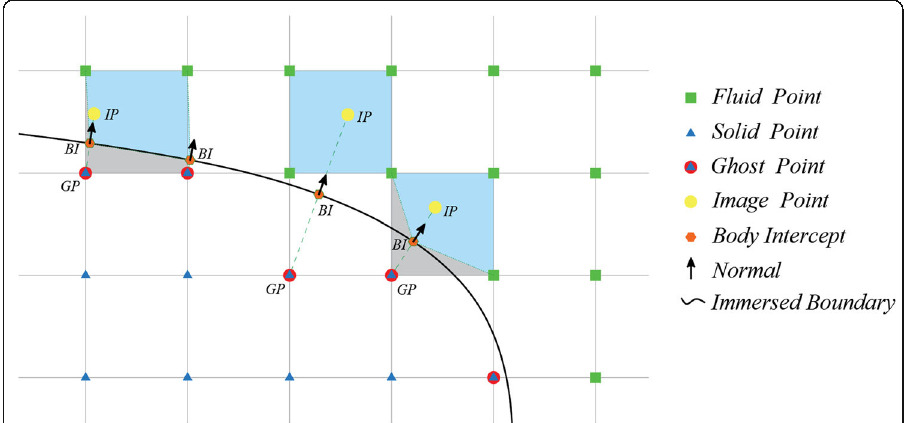
Fig. 1 Different kinds of points on a Cartesian